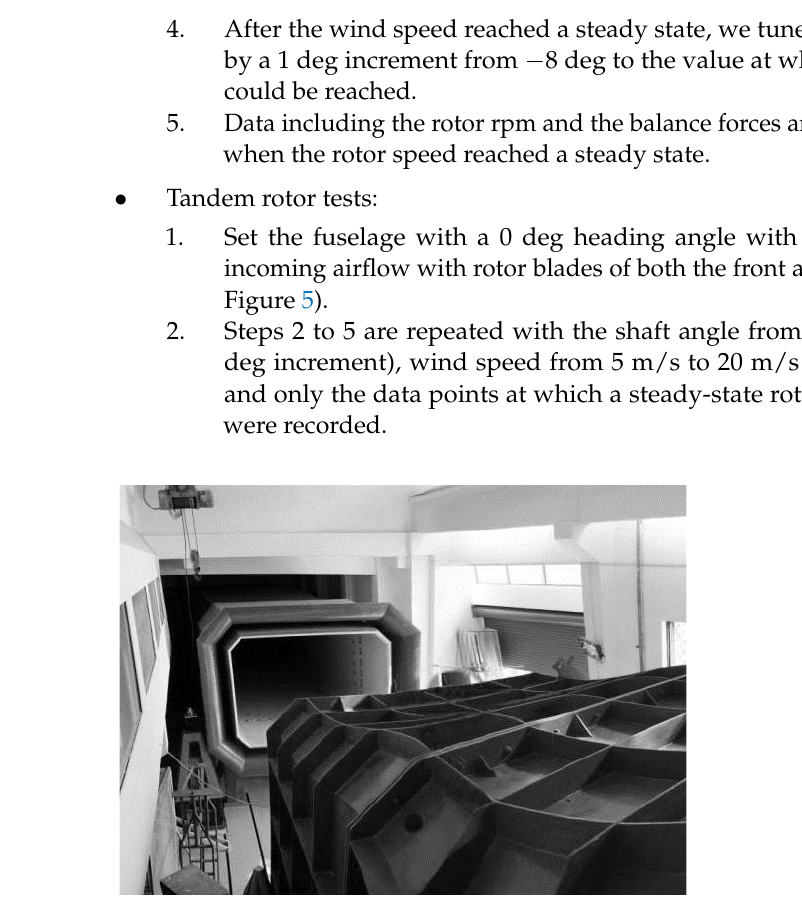
Figure 3. Helicopter subsonic wind tunnel.